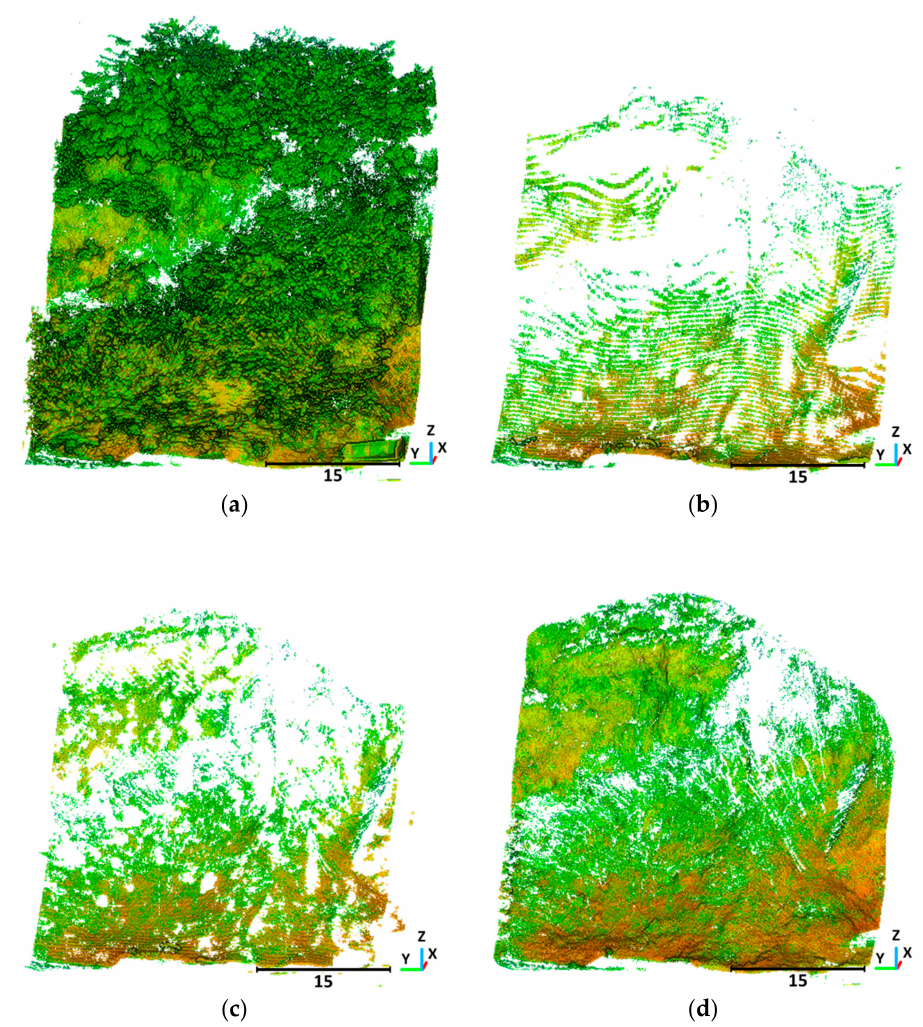
Figure 9. Filtering result of site B: ( a ) original data; ( b ) the lowest points; ( c ) seed points for PCA-TIN; ( d ) final